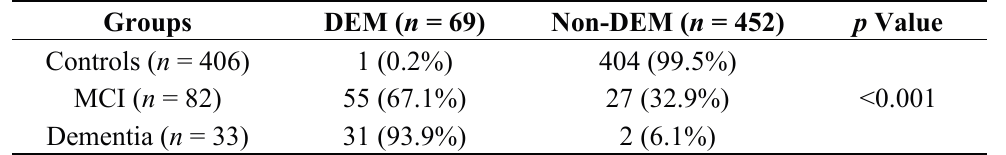
Table 3. Distribution of DEM and non-DEM participants in clinical consensus diagnostic groups.